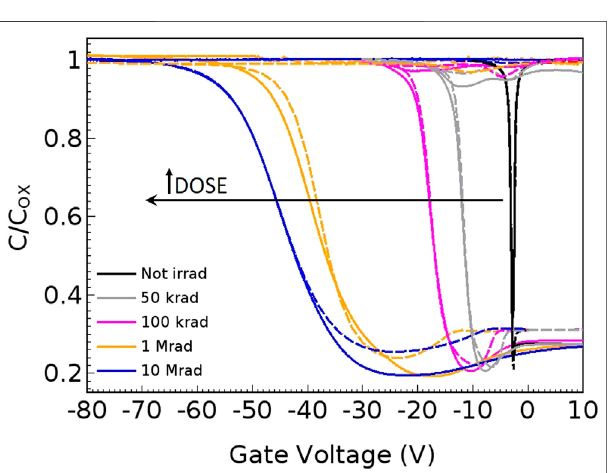
FIGURE 4 | C-V characteristics of HPK MOS capacitors: comparison between measurements and simulations (no p-spray isolation layer). Measurements in solid line and simulations in dashed line.